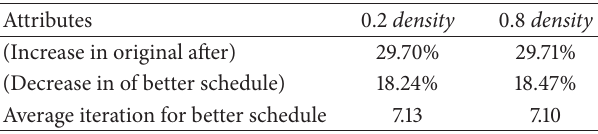
Table 7: Performance for DAGs with different density